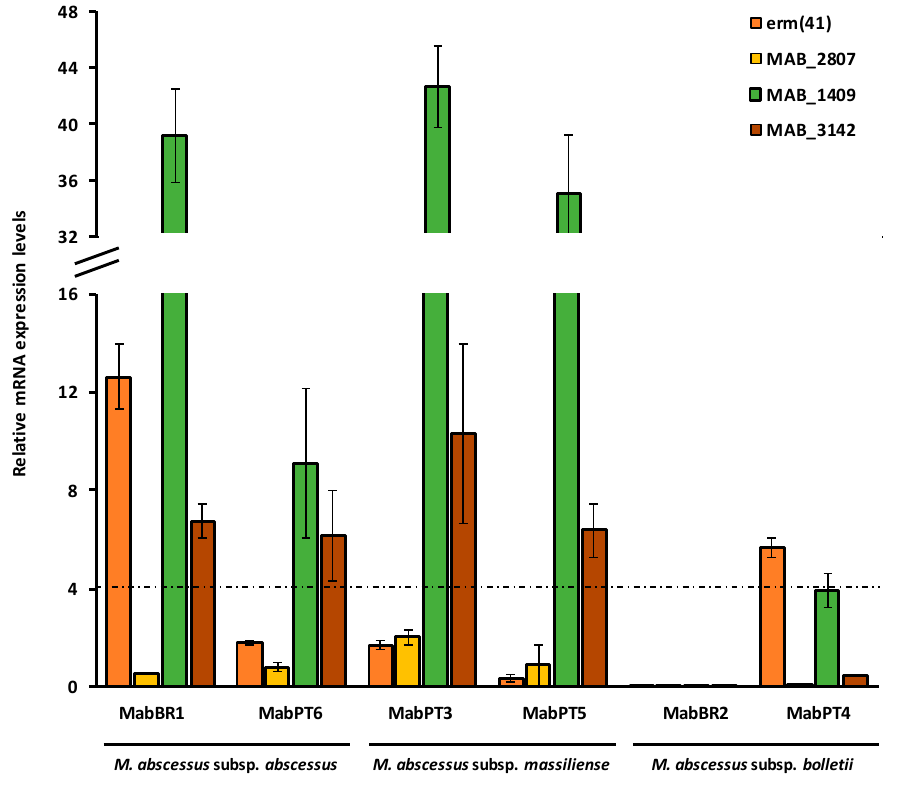
Figure 2. Relative quantification of efflux pump gene mRNA levels in the M. abscessus strains exposed to clarithromycin. Strains were grown in MGIT medium for the MGIT 960 system in the presence of half MIC of clarithromycin (see Table 1 for MICs). The relative expression of the efflux pump genes was evaluated comparing the relative quantity of the respective mRNA in the presence of clarithromycin to the respective unexposed strain. A level of relative expression equal to 1 indicates that the expression level is identical to the non-exposed parental strain. Genes showing expression levels above four were considered overexpressed (black dashed line in the graph).